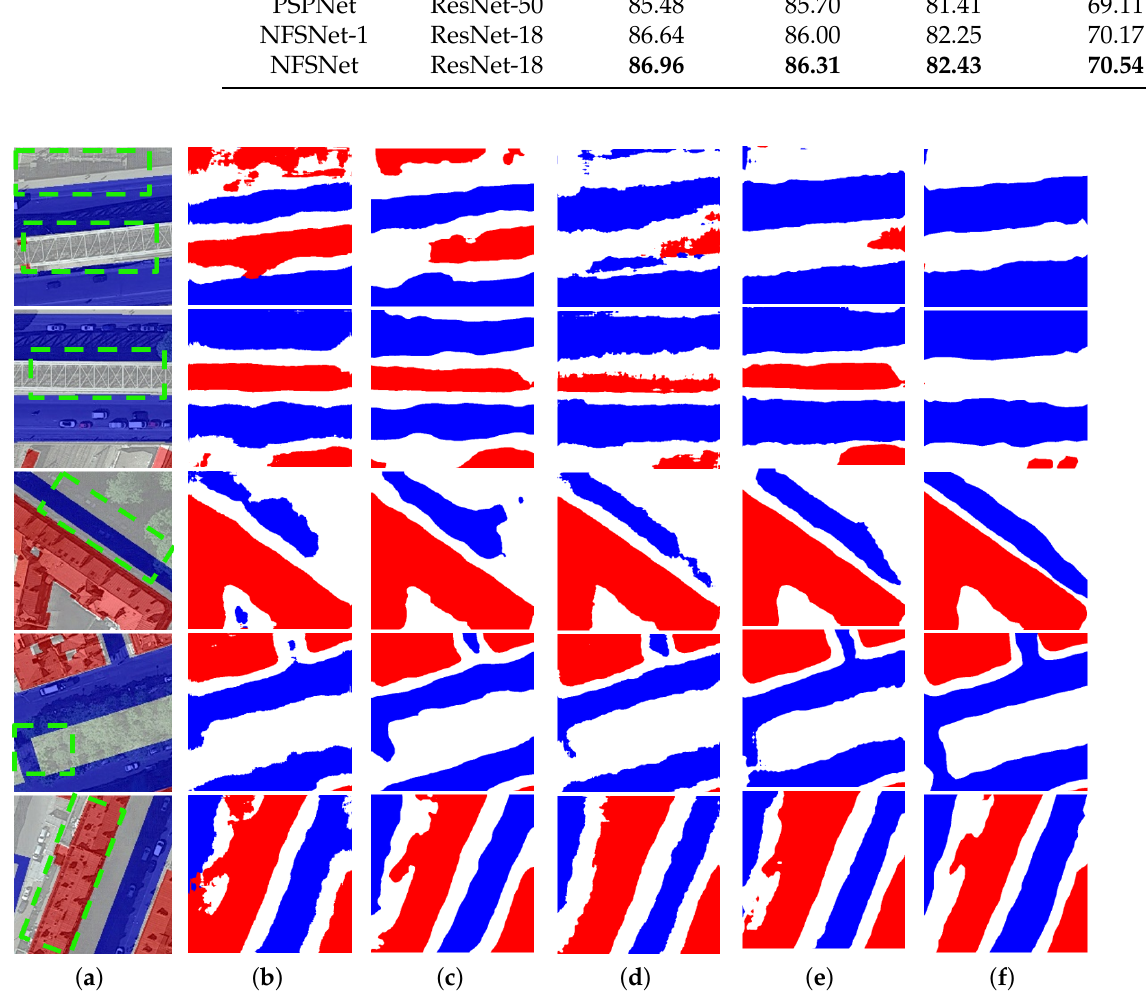
Figure 6. Visual effect comparison of Potsdam-A test set; ( a ) the superposition of the original image and the label; ( b ) U-Net; ( c ) FCN-8S; ( d ) DeeplabV3+; ( e ) PSPNet; ( f )